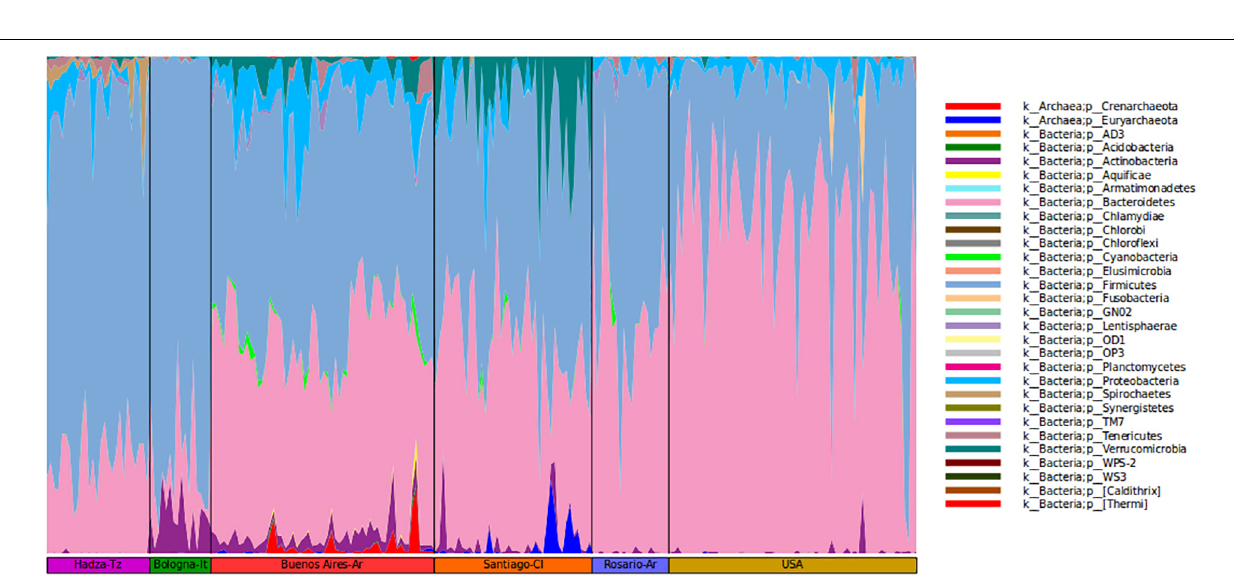
Frontiers in Microbiology |